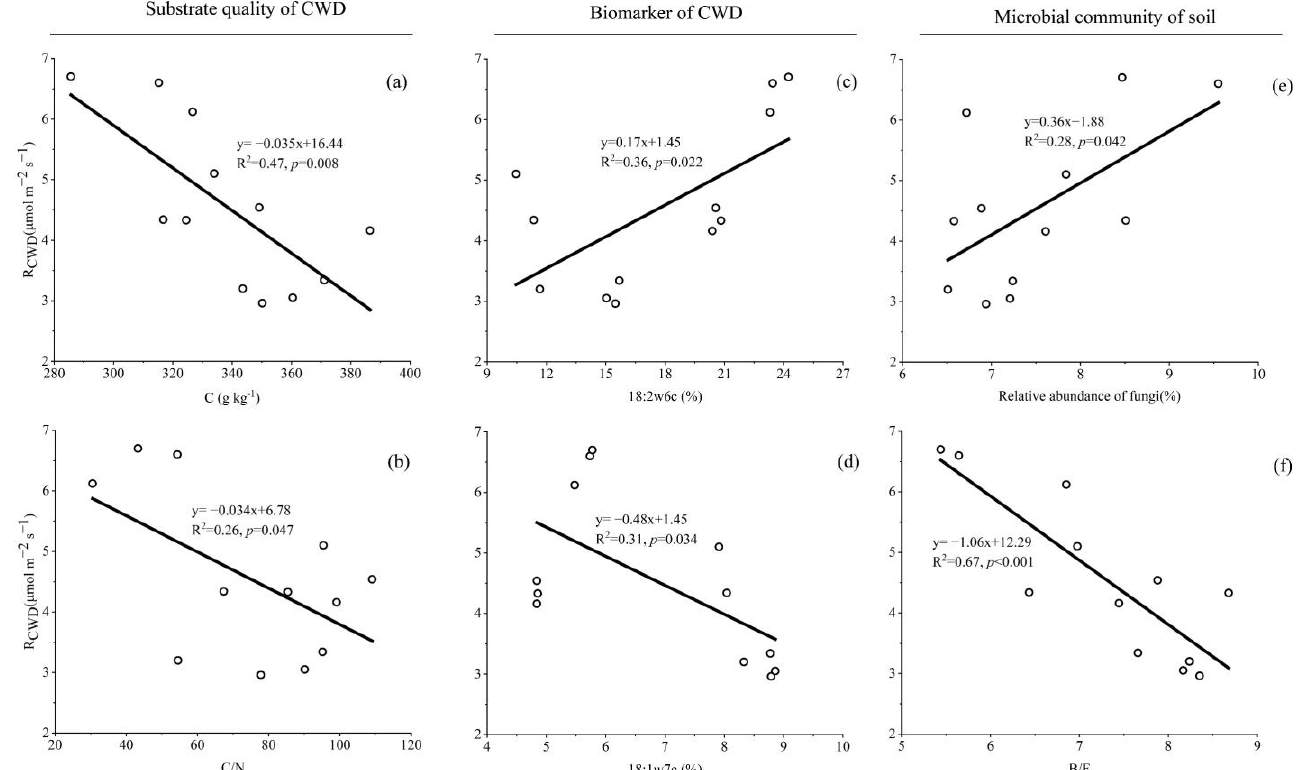
Figure 4. Univariate linear regression of R CWD and substrate quality of CWD ( a , b ), relative abundance of the biomarker of CWD ( c , d ), relative abundance of soil fungi ( e ) and soil B/F ( f ). R CWD : respiration rate of CWD; CWD: coarse woody debris. Table 6. The soil microbial PLFAs (nmol g −1 ) and relative abundance (%) ( n = 3. means ± 1 se) under the CWD of two tree types ( C. japonica vs. P. strobilacea ) in the two habitats (CF vs. DBF) after de- composition. Different lowercase letters indicate significant differences ( p < 0.05). CWD: coarse